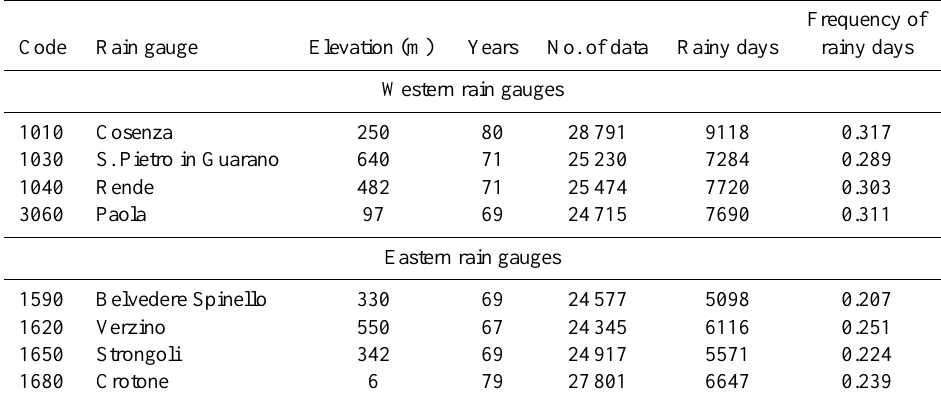
Table 1. Main statistics of daily rainfall occurrence process for the selected rain gauges.